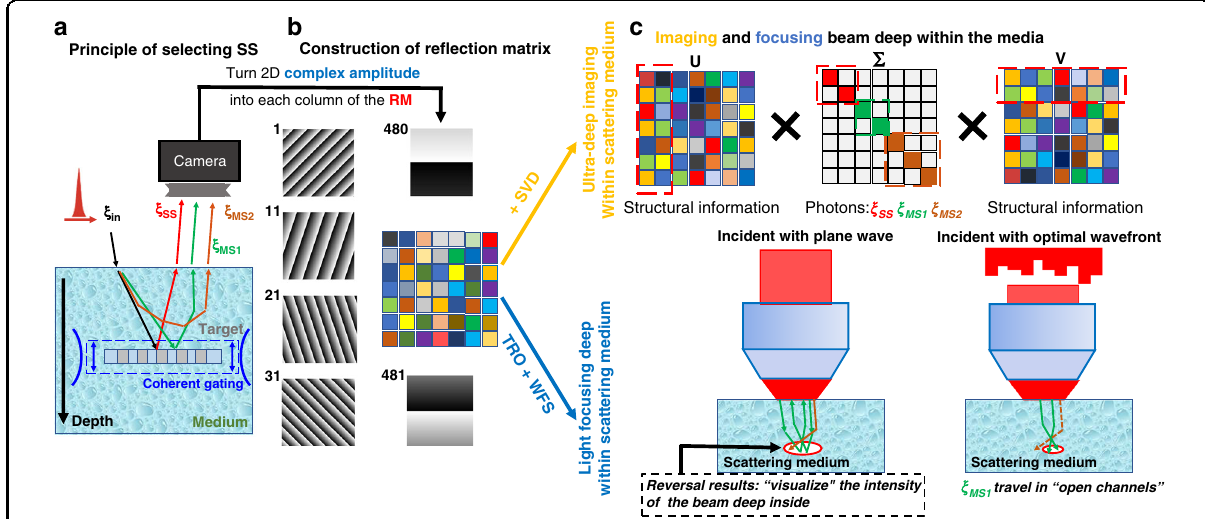
Fig. 1 Overview principle of our method to enhance the delivery of light energy deep into the medium. a Classi fi cation of three types of back-scatted photons, ξ SS , ξ MS1 , and ξ MS2 photons. b A point-by-point scanning strategy to construct the huge re fl ection matrix. c The theory of (1) time-reversal operator to separate ξ SS , ξ MS1 , and ξ MS2 photons; (2) wavefront shaping to focus light within the